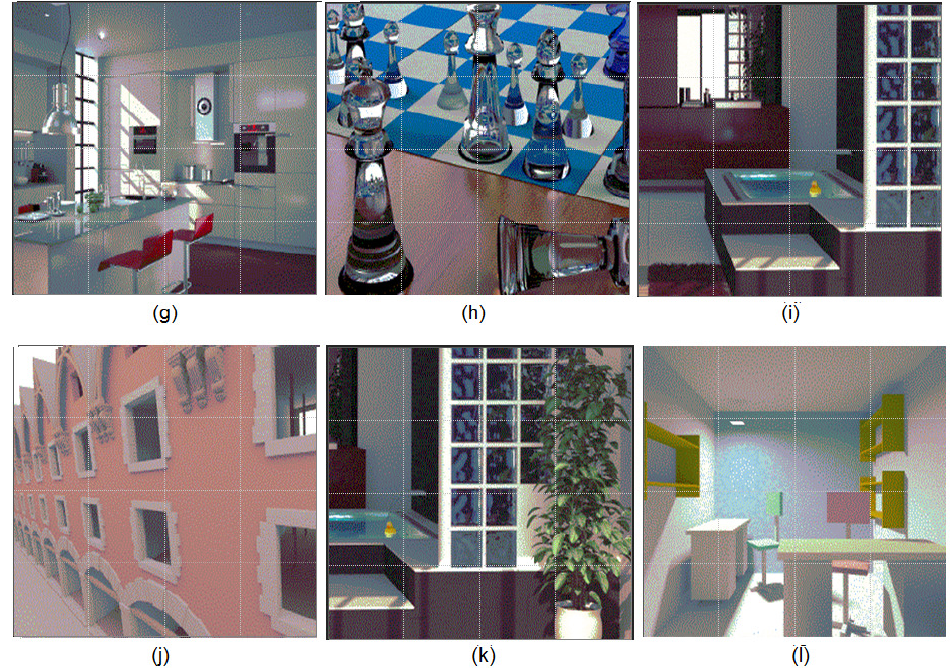
Figure 2. Rendering results for the sub-images of the scenes with 800 × 800 resolution. The scenes with 800 × 800 resolution ( g – l ) are used to illustrate view-dependent indirect illumination effects caused by strong inter-reflections between the diffuse and specular